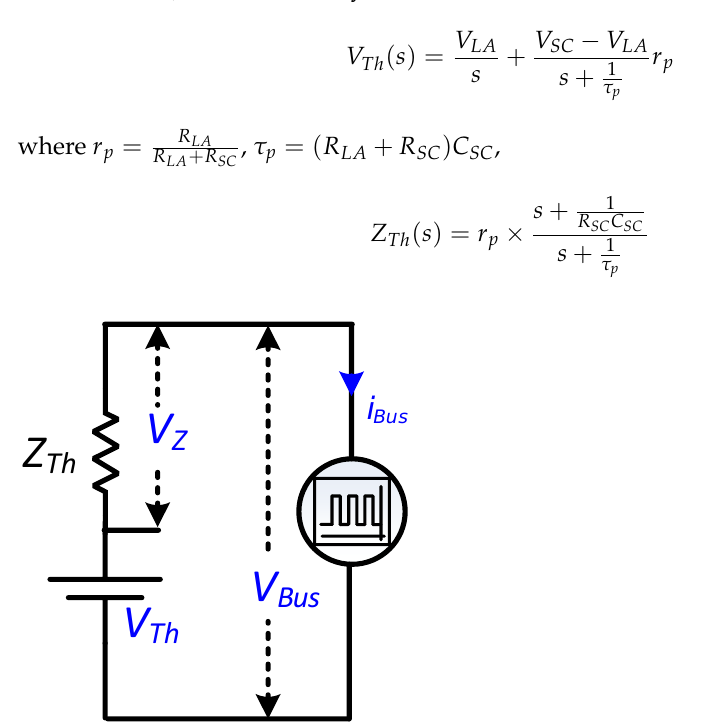
Figure 6. Thevenin’s equivalent model of the passive HESS configuration.